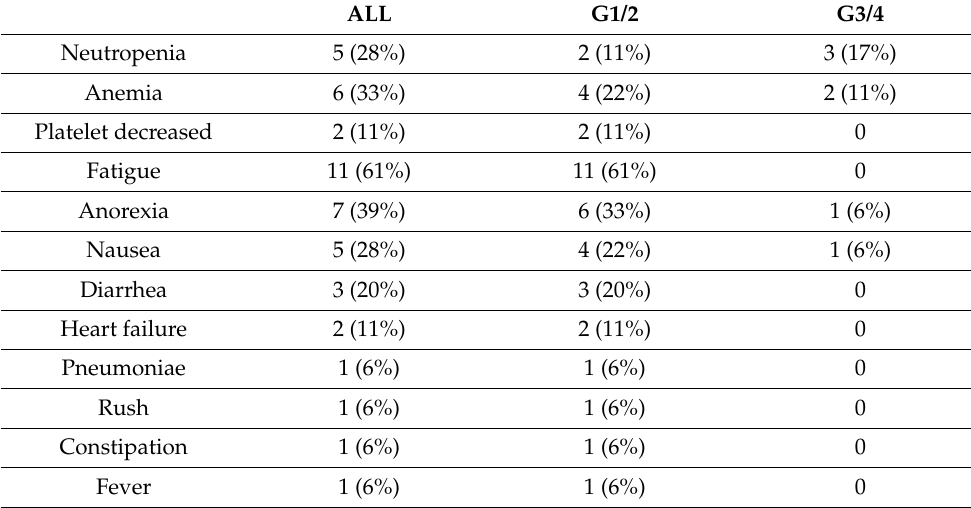
Table 2. Distribution of drug-related adverse events.